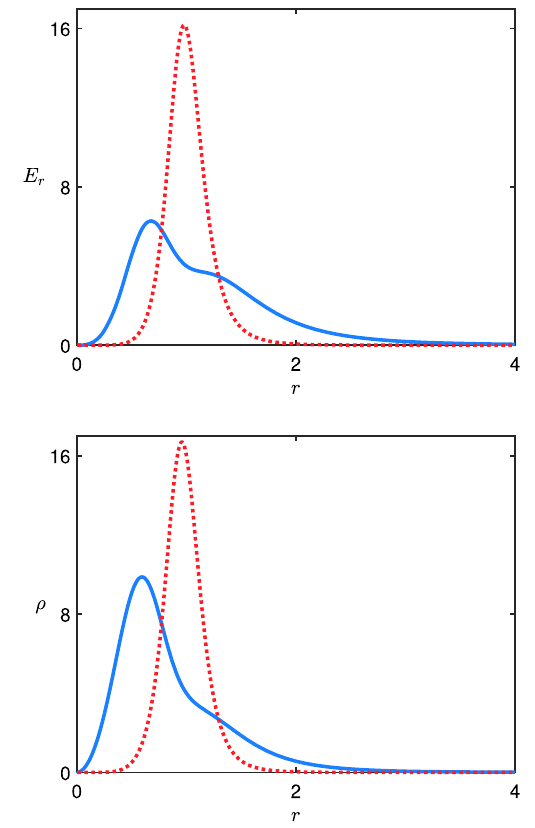
Fig. 2 The radial component of the electric field (top) for e = 1 and the energy density (bottom) associated to the model in Sect. 3.1 for σ = 5, with k = 1 (solid, blue line) and 2 (dotted, red line)